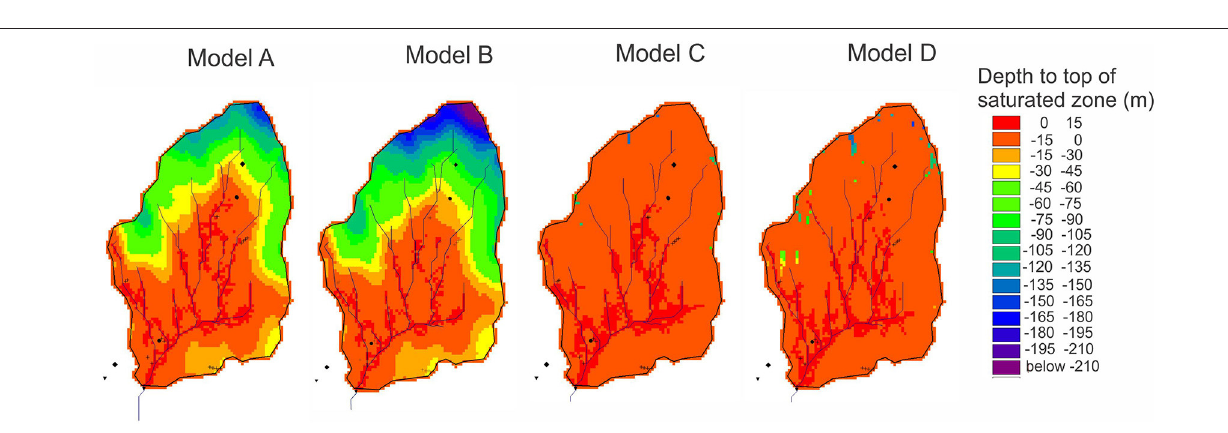
Table 1 . Only the main water balance components are